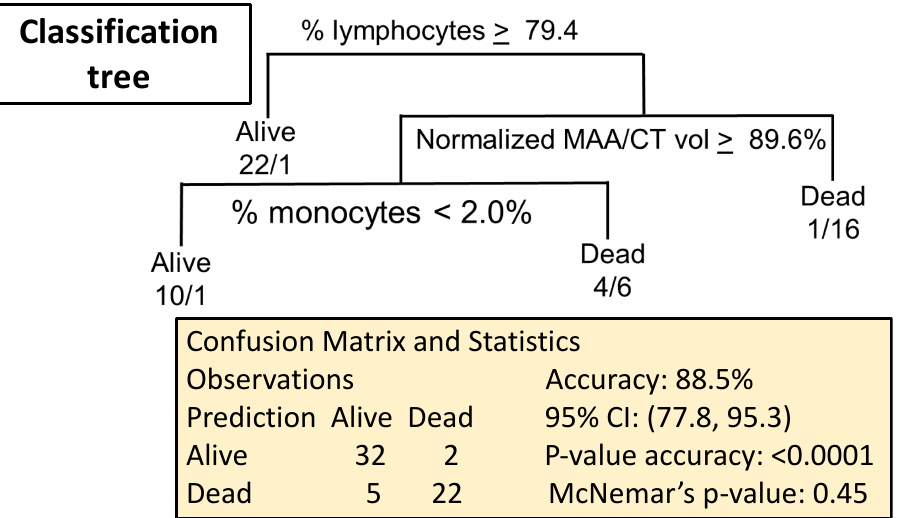
Figure 5. Prediction rules for 60-day status were developed using a classification-tree (CART) ap- proach. In the plots, the splitting criterion is listed at each decision point; the left branch corresponds to “YES” and the right branch to the “NO”. The Alive/Dead label at the bottom of the tree indicates the classification of the observations falling into that group, with the numbers indicating the actual number of observations (alive/dead). Splits on a missing value are handled by either splitting on a correlated “surrogate” variable, or by going with the majority. McNemar’s p -value: